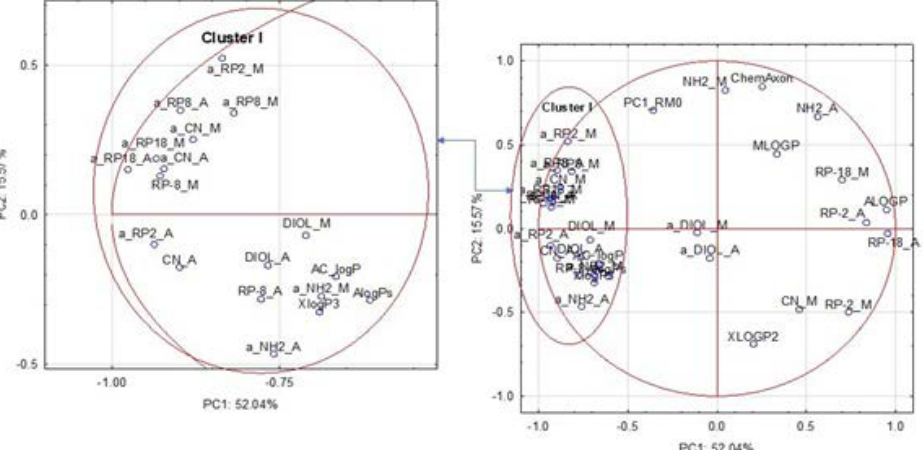
Figure 6. The loadings principal component (PC) plots based on the autoscaled lipophicility results for the studied compounds picturing the variables in two-dimensional space.